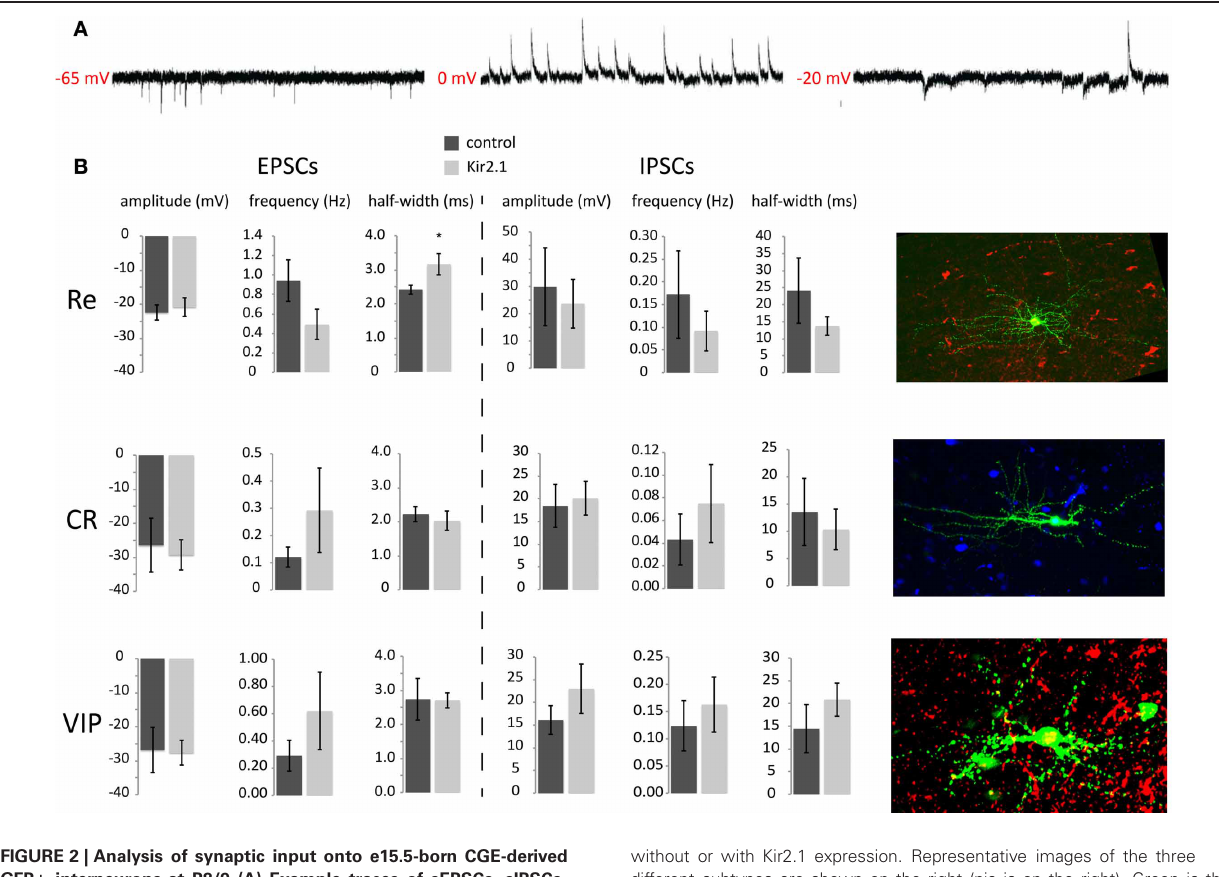
without or with Kir2.1 expression. Representative images of the three different subtypes are shown on the right (pia is on the right). Green is the GFP, showing the axo-dendritic arborization of each one and red or blue is the respective marker for Reelin, Calretinin, or VIP ( ∗ p ≤ 0 . 05, unpaired t